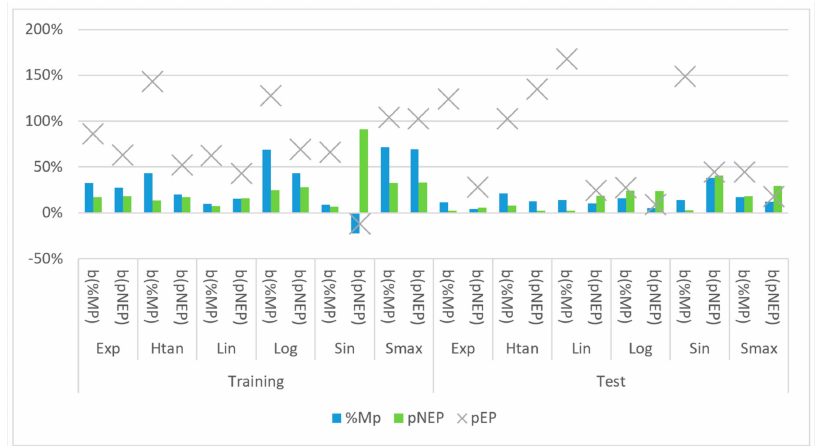
Figure 5. The highest values of the %MP and pNEP indicators, broken down by type of activation functions in the output layer, from the perspective of the training set.